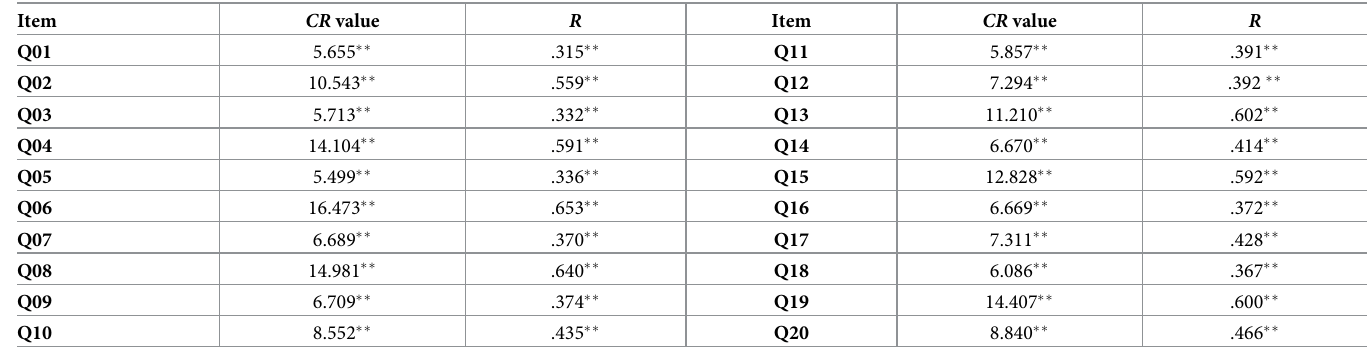
Table 1. The CR value and correlation between each item and total score. Item